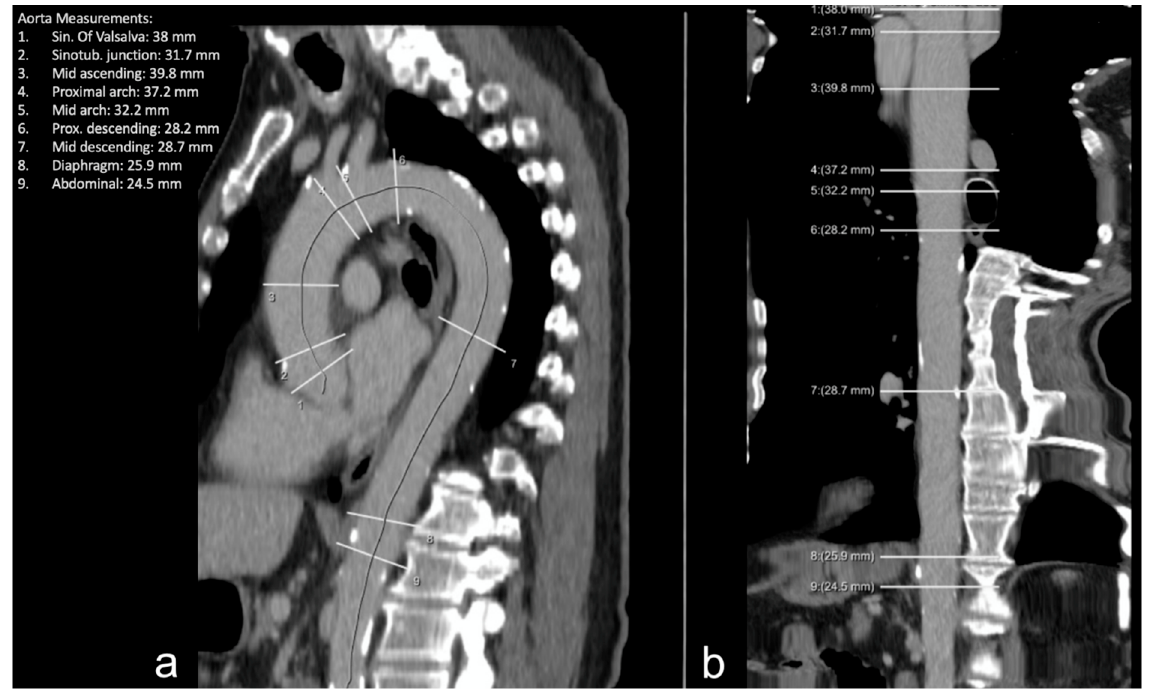
Figure 3. Example of the thoracic aorta imaged via CT in plane reformatted along the center line ( a ) and straightened reconstruction ( b ). White lines: measurement planes of the diameter at each dedicated location.